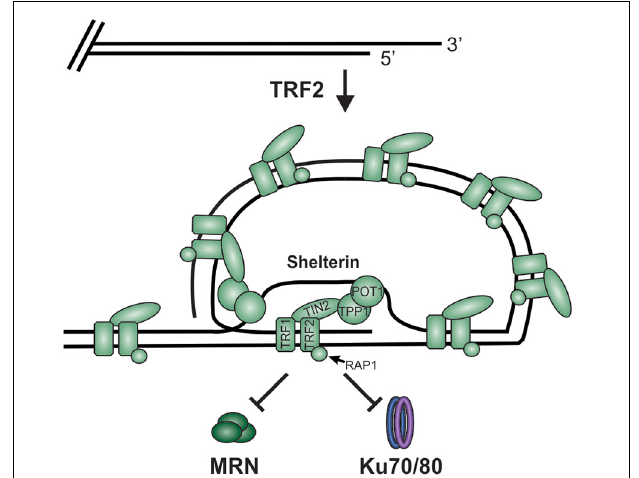
FIGURE 5 | TRF2 facilitates telomere loop (t-loop) formation by promoting invasion of the G-overhang into the duplex region to form a displacement loop (D-loop). This t-loop combined with shelterin blocks MRN and Ku from accessing the chromosome ends and initiating DSB repair.